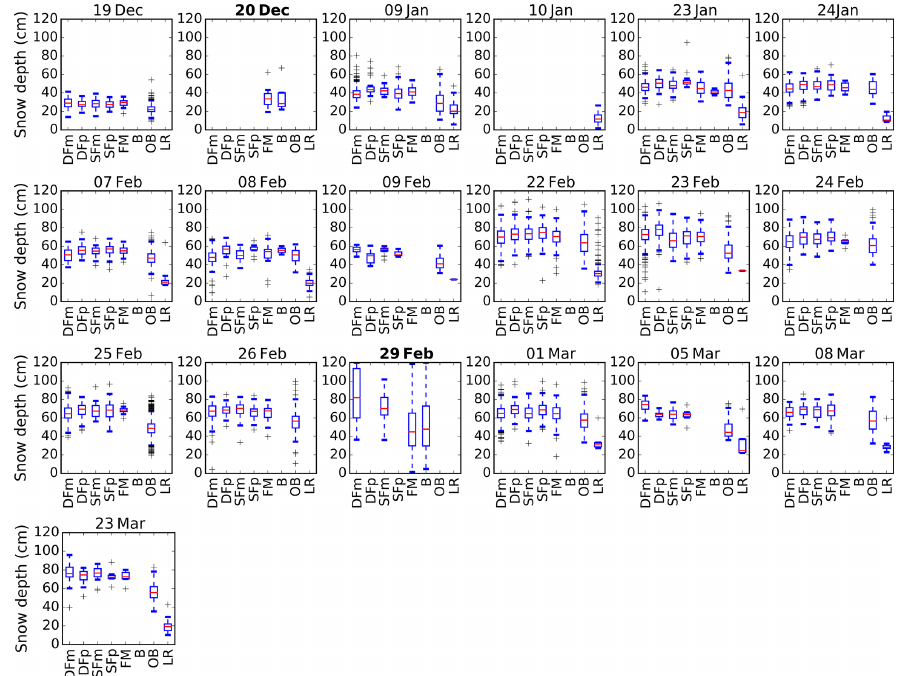
Figure 3. Box plots of measured snow depth within each land cover group during the different field measurement days. Measurements from the Saariselkä test site are indicated in bold.